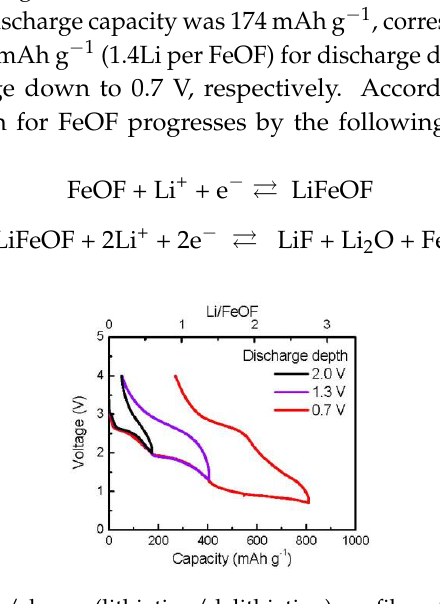
Figure 1. Typical discharge/charge (lithiation/delithiation) profiles of FeOF cathode vs. Li cells with different discharge depth down to 2.0 V (solid line), 1.3 V (dashed line), and 0.7 V (dotted line),